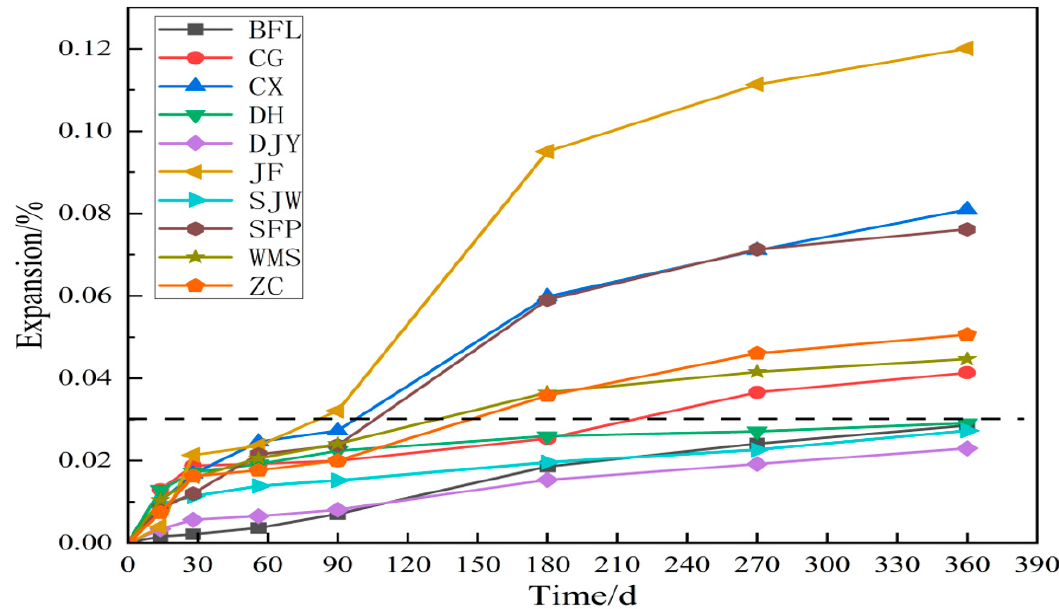
Figure 6. The expansion of the concrete prisms prepared according to ASTM C1105.